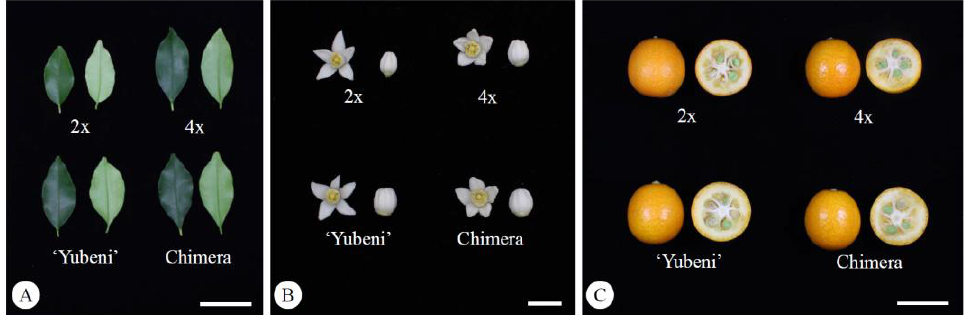
multiple test, 1% level.